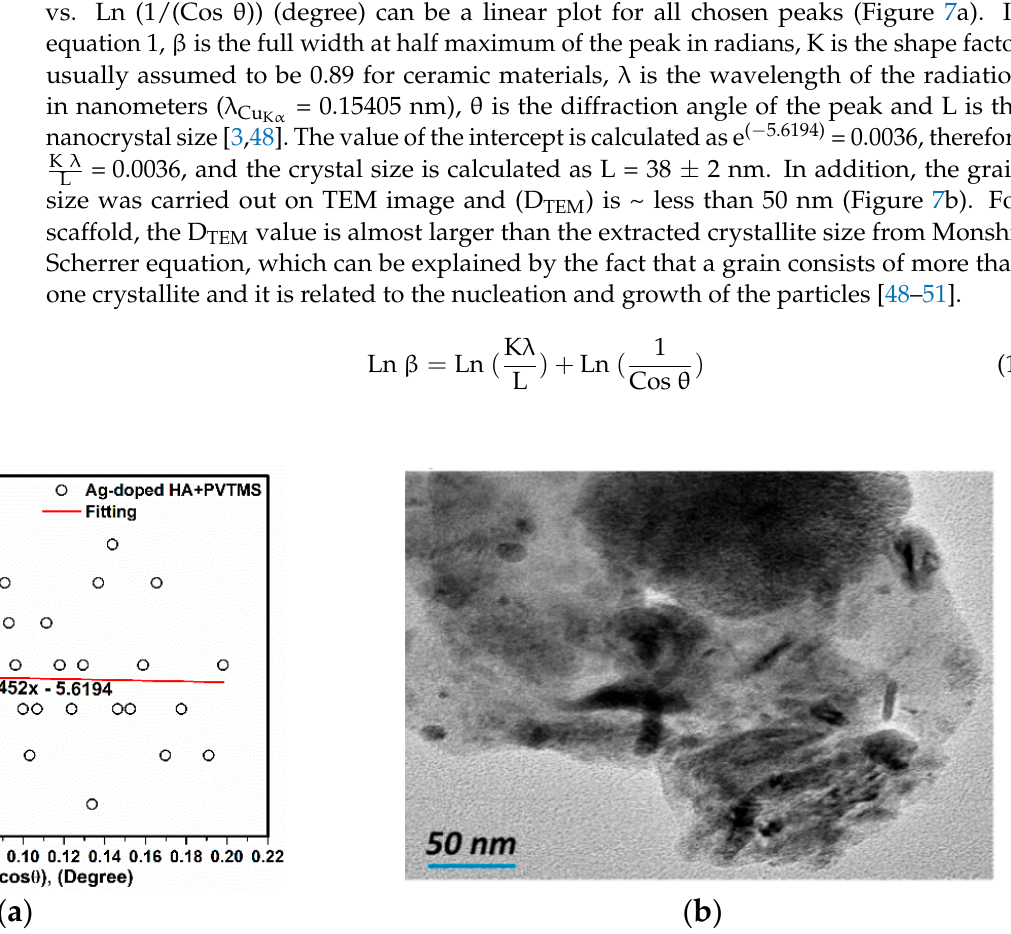
Figure 7. ( a ) Linear plots of the Monshi-Scherrer equation and ( b ) TEM image of scaffold.